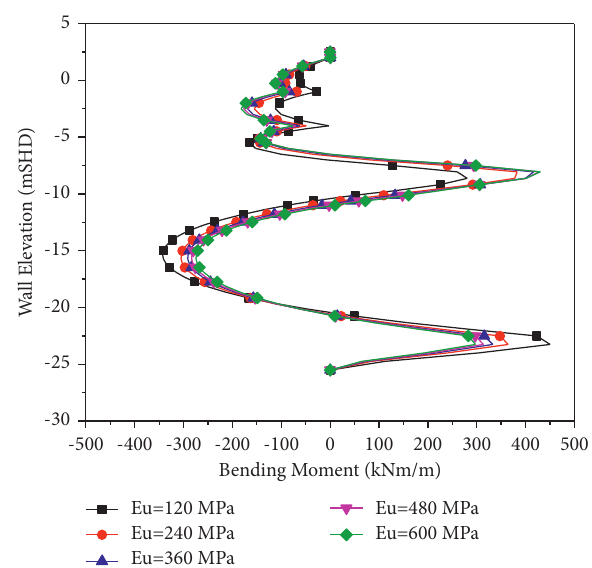
Figure 14: The effect of ground improvement Eu on wall bending